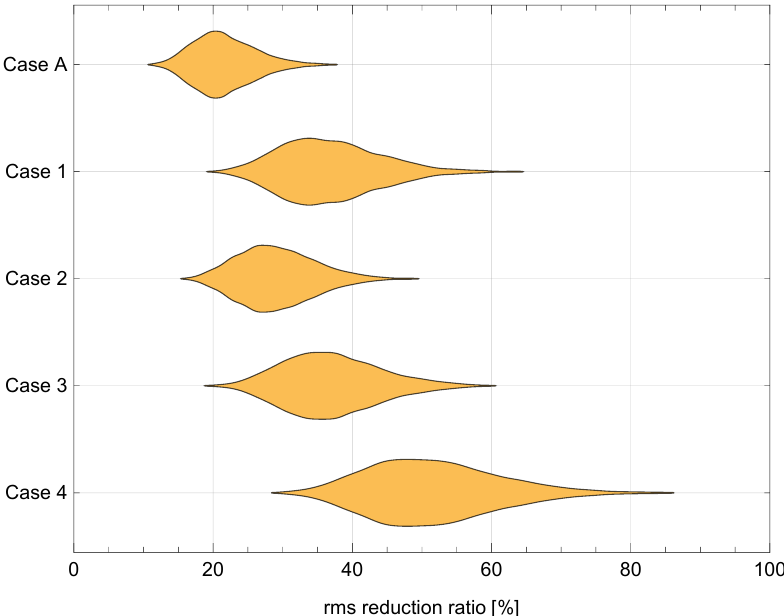
Figure 6. Distribution plots (qualitative representations of the empirical probability density functions) of the rms reduction ratios for the five controlled structures.